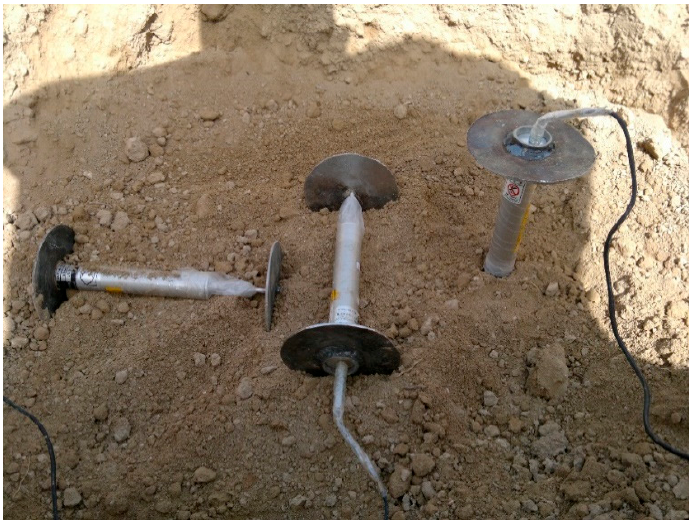
Figure 2. Placement of strain transducers including endplates inside the soil profile in longitudinal, lateral and vertical directions.